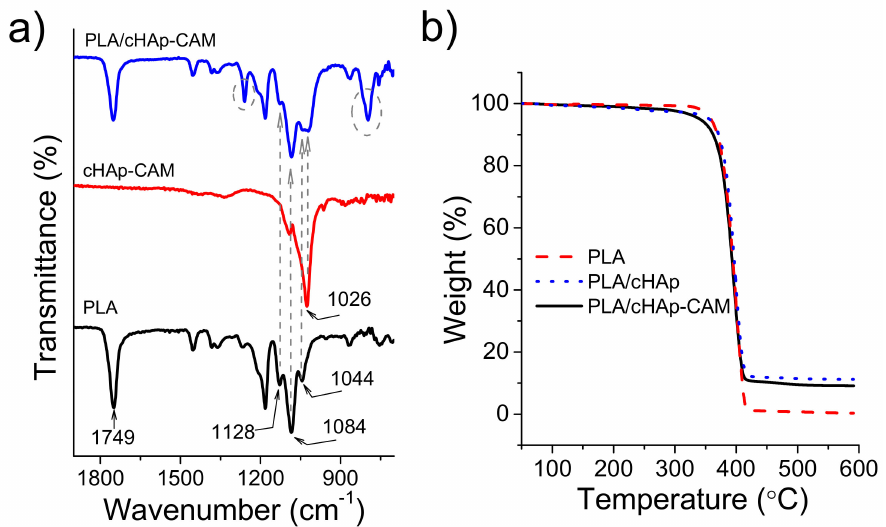
Figure 10. ( a ) FTIR spectra for PLA (black), cHAp-CAM (red) and the PLA sca ff old incorporating cHAp nanoparticles encapsulating CAM (blue). ( b ) Thermogravimetric curves of PLA (red), PLA microfibers incorporating cHAp (blue) and PLA microfibers incorporating CAM loaded cHAp nanoparticles